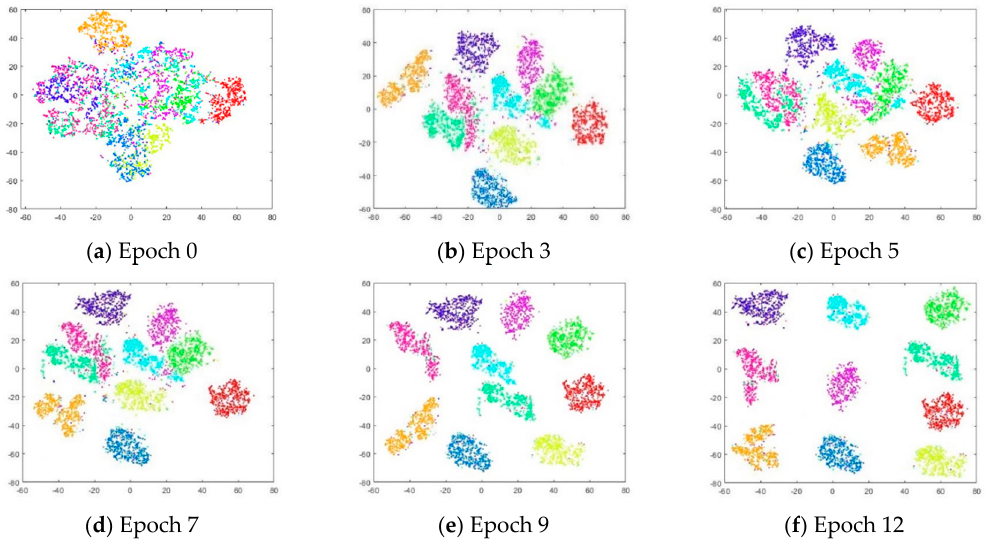
Figure 5. t ‐ SNE (T ‐ distributed Stochastic Neighbor Embedding) visualizations for clustering to show the discriminative capability of proposed approach on MNIST dataset. Note separation of clusters from epoch 0 to epoch 12.